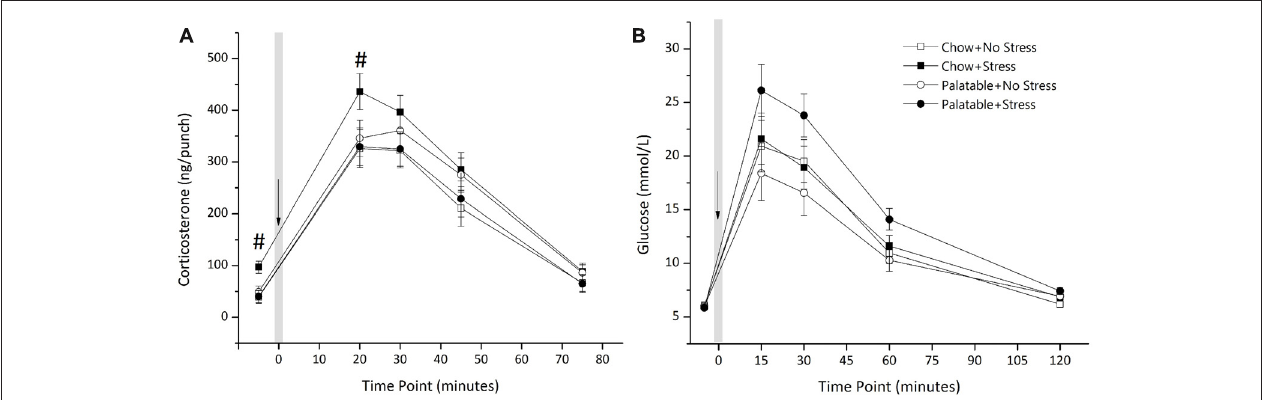
FIGURE 4 | Effects of access to a palatable diet and juvenile stressor exposure on glucose tolerance and HPA-axis response to a mild stressor. (A) Juvenile stressor exposure increased corticosterone levels at baseline and 20 min after an air-puff stressor in adult chow-fed rats but not in rats that had access to the palatable diet. Air-puff administered at t = 0 as indicated and the volume of each punch was 2.5 µ L. (B) Glucose levels were elevated at 15, 30 and 60 min after intraperitoneal administration of dextrose (0.75 g/mL) at t = 0 min, as indicated, in all groups. However, there was no significant effect of diet or stress conditions. # Significantly different from other conditions ( p <